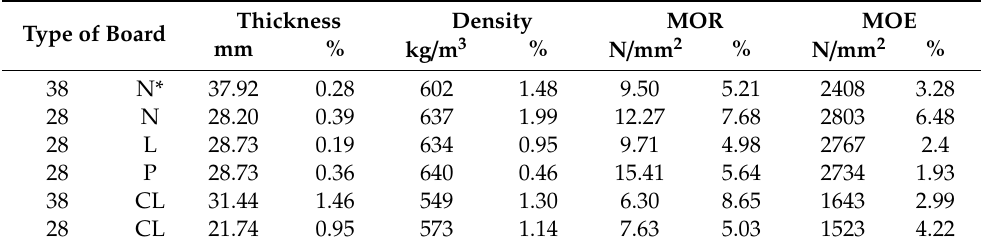
Table 5. Physical and mechanical properties of industrial